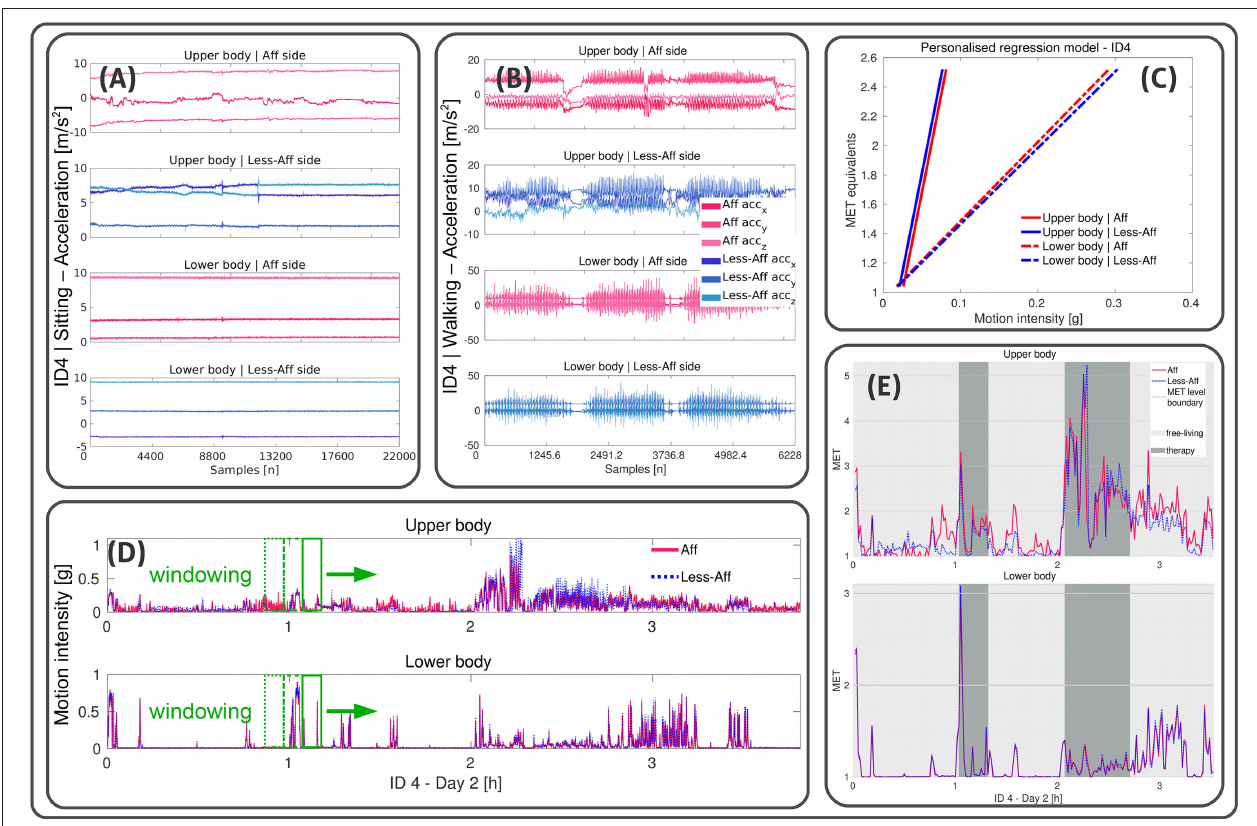
FIGURE 2 | Illustration of the personalized MET estimation using linear regressions. Example data shown from recording day two of patient ID4 (walker). (A,B) Illustrate x-, y-, and z-acceleration data derived from wrist- and thigh-worn sensors of affected and less-affected body sides, and upper and lower body, respectively during sitting and walking. (C) Visualizes the regression model for each limb. Acceleration data in m were further processed to derive the motion intensity in g -values. s 2 Reference MET equivalents were used to derive α and β using linear regression. (D) Shows the motion intensity for each limb derived during a complete recording day including free-living and clinician guided therapy. A non-overlapping windowing extracts data of 1min epochs to estimate MET equivalents. (E) Illustrates estimated MET equivalents for each limb. Free-living and clinician guided therapy settings are highlighted for the upper and lower body affected and less-affected